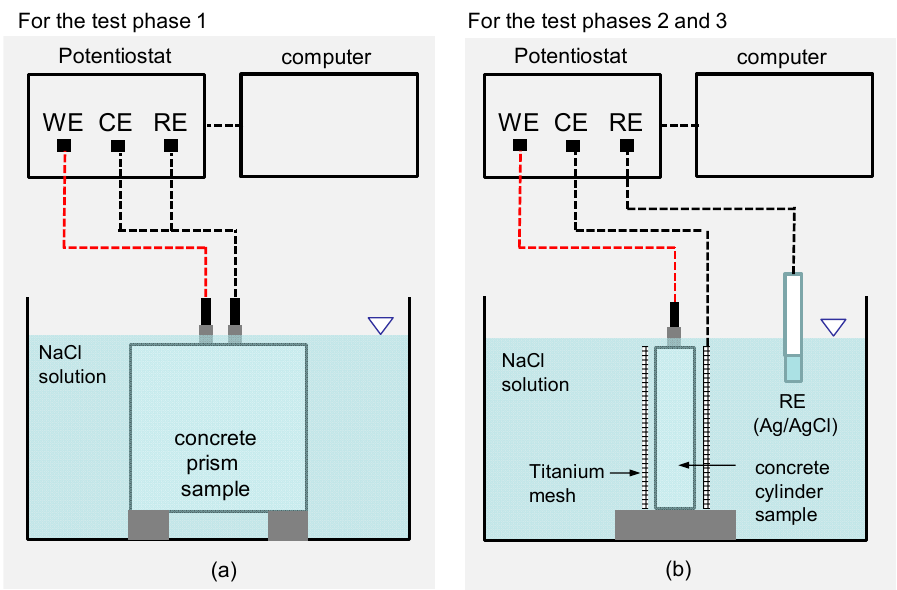
Figure 5. Illustration of test setups for electrochemical impedance spectroscopy (EIS) using: ( a ) the two-electrode system for the concrete prism samples in the test phase 1, and ( b ) the three-electrode system for the concrete cylinder samples in the phase 2.